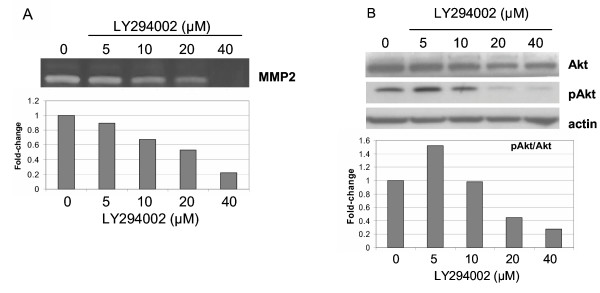
Inhibition of PI3K reduces MMP expression in Comma/PDK1 cells. Cells were treated for 24 hr with 5–40 μM LY294002. A, Media was concentrated and assayed for MMP activity by zymography as described in Fig. 3. Bar graph represents a densitometric scan of the zymogram. B, Cells were lysed and analyzed by western blotting for levels of Akt, Akt1pS473 and β-actin. Bar graph represents a densitometric scan of the western blots normalized for β-actin levels.